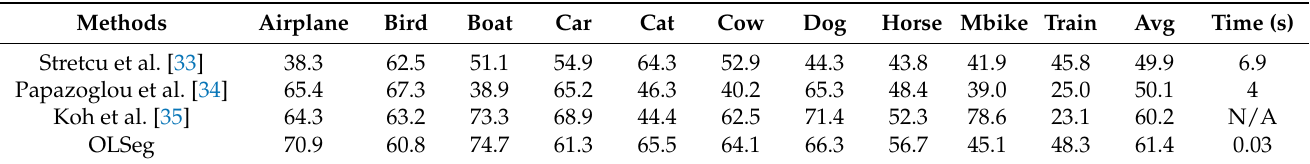
Table 2. Comparisions of CorLoc (%) on the YouTube Object dataset. Time (s) denotes the processing speed of each